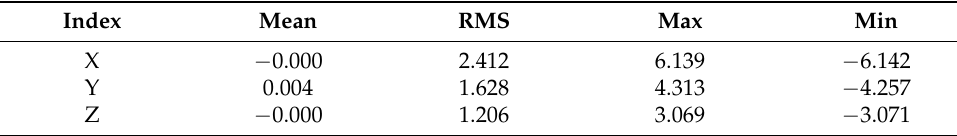
Table 11. Initial positioning accuracy of TH-1 HR camera.